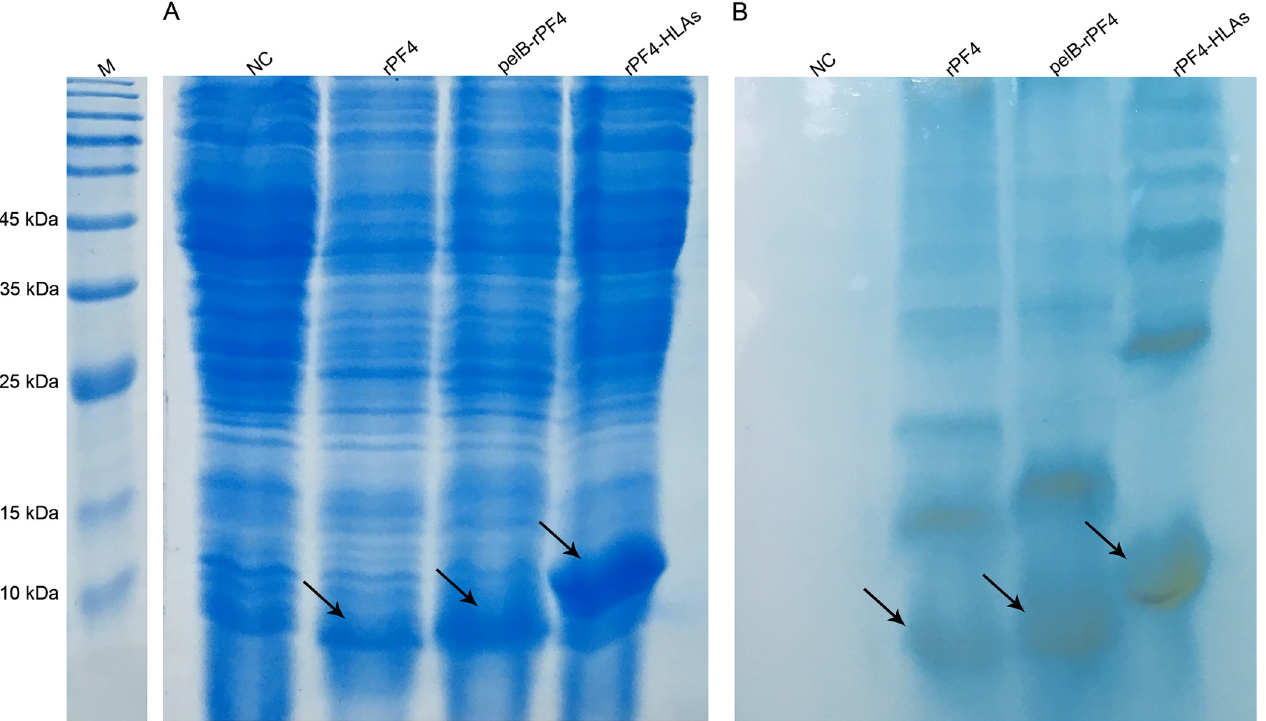
Fig 3. Western blotting confirmation of the cytoplasmic expression by the pelB-rPF4, rPF4-HLAs, and rPF4 constructs. The protein expression and sample preparation were carried out similar to the Fig 2. (A) Depicts the SDS-PAGE gel and (B) depicts the result of the Western blotting analysis performed on the same gel indicated in (A). Other bands visualized in the Western blotting analysis indicate various oligomeric states of the rPF4. In addition, compared to the other rPF4 variants, the migration of rPF4-HLAs protein has been retarded due to its additional HLA signal sequence. The rPF4 proteins respective to each construct was verified by specific anti-PF4 antibody. NC represents the negative control lacking the rPF4 coding sequence. M denotes the molecular weight